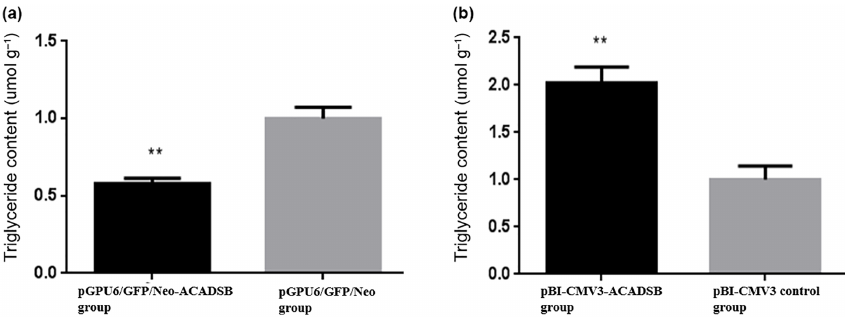
Figure 3. Comparison of the TG content of bMECs which transfected with RNAi vector or overexpression vector. (a) The TG content of bMECs which transfected with pGPU6/GFP/Neo-ACADSB vector and pGPU6/GFP/Neo control vector. (b) The TG content of bMECs which transfected with overexpression plasmid pBI-CMV3-ACADSB and pBI-CMV3 control